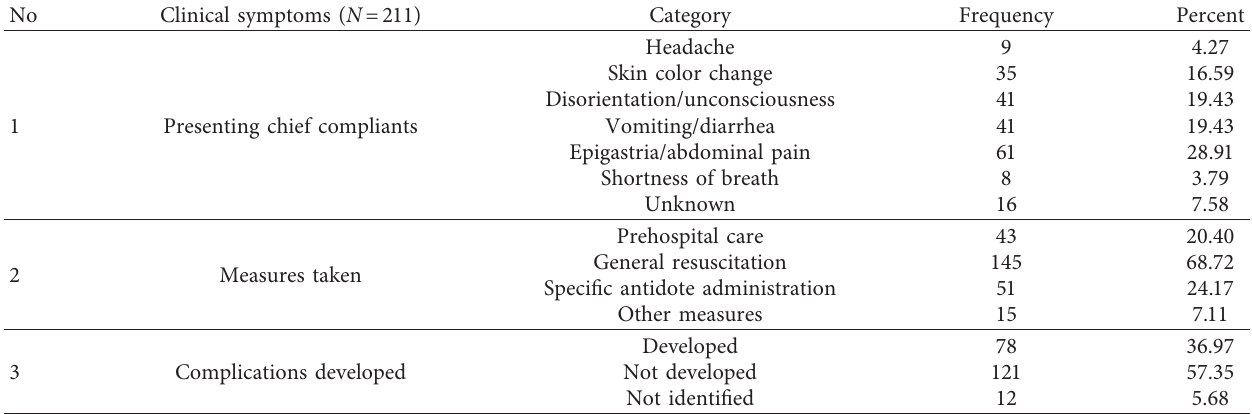
Table 4: Symptoms, treatments provided, and complications developed in Nekemte, Ethiopia, 2018. No